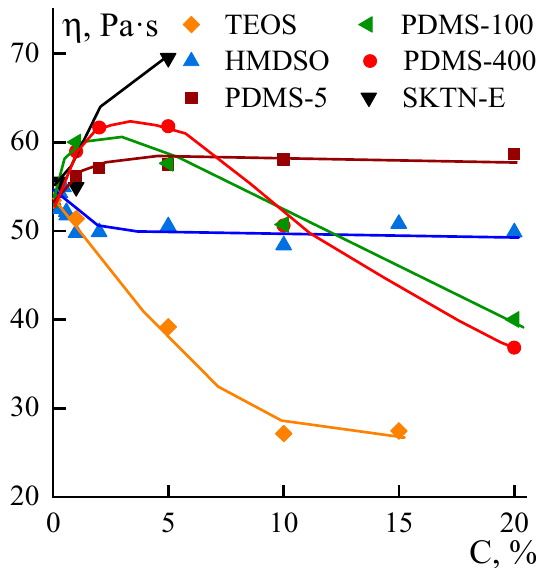
Figure 9. Dependences of viscosity, measured at a shear rate of 1 sec − 1 , of the compositions on the content of various PDMS.